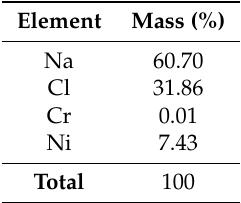
Figure 16. SEM images of the coatings after 60 days of immersion in seawater: ( a ) P1 with 0 wt. % LLE; ( b ) P2 with 3 wt. % LLE; ( c ) P3 with 6 wt. % LLE; ( d ) P4 with 9 wt. % LLE; ( e ) P5 with 12 wt. % LLE. Table 9. Distribution of the elements on P2 after 60 days of immersion in